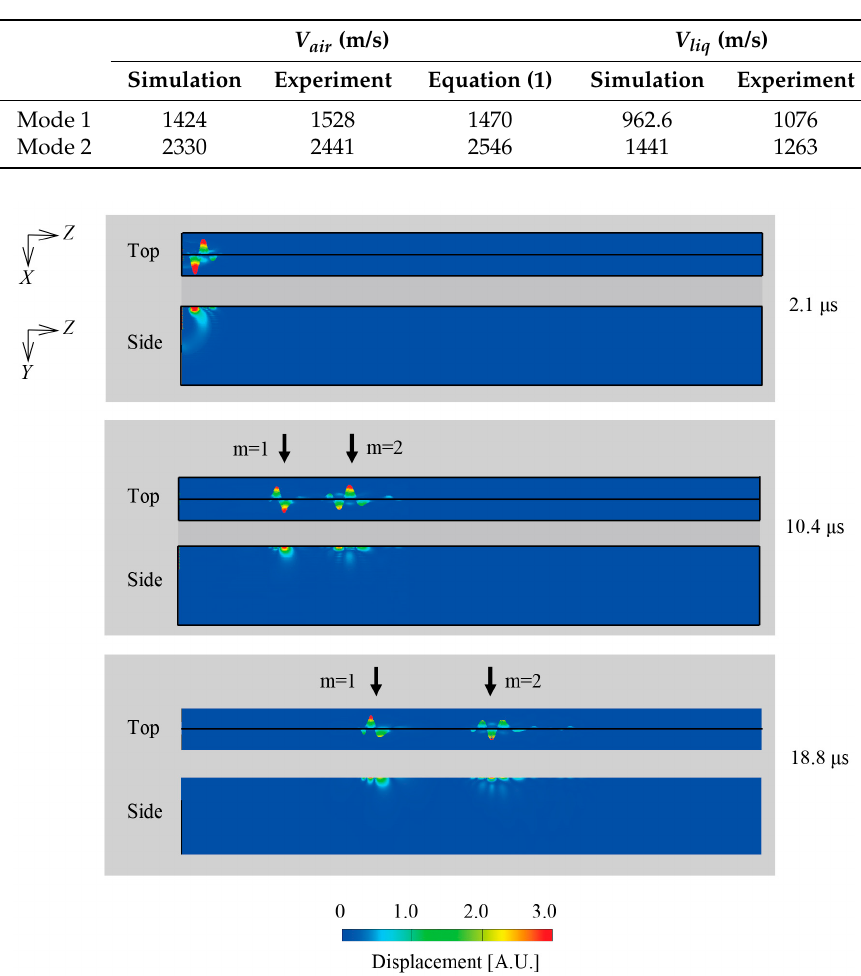
Figure 4. Simulation results of wedge wave propagating in the air. Top and side view of the waveguide is shown from 2.1 to 18.8 µ s. The colored waveform represents degrees of displacement. The faster wedge wave is mode 2 and the slower one is mode 1.